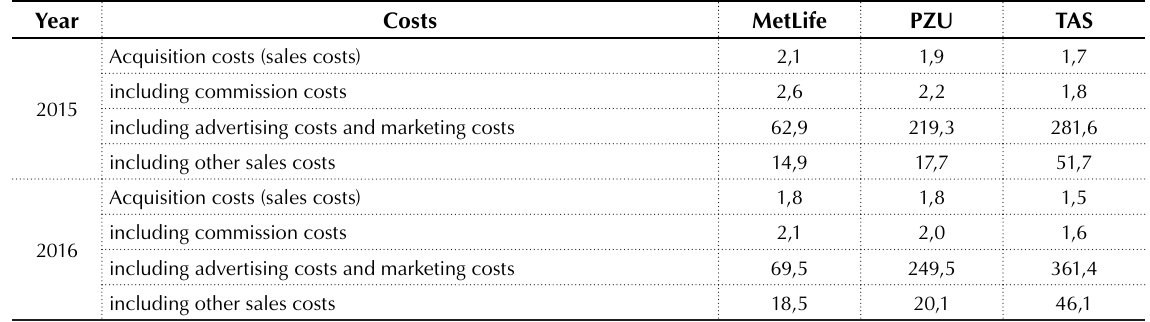
Source: Sites of the companies.